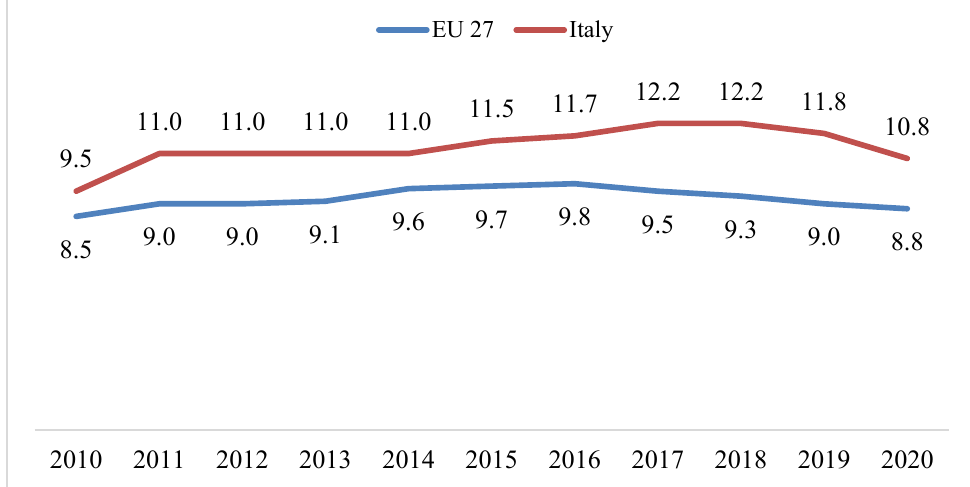
Figure 9. NEET in European countries, 2017–2021. Source: own elaboration on the Eurostat database. Particularly noteworthy is that in 2021, Italy was the fourth European country 13 for early leavers from education and training among young people aged 18–24 years (12.7% in Italy vs. 9.7% in Europe). However, this percentage was 17% in 2012 (12% in Europe), experiencing a decrease in the last 10 years (Figure 10).